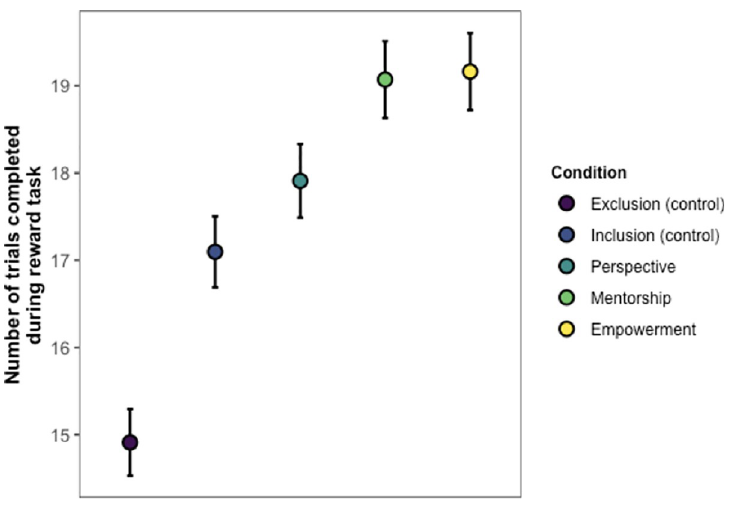
Fig 9. Main results from Study 5. Error bars show ± 1